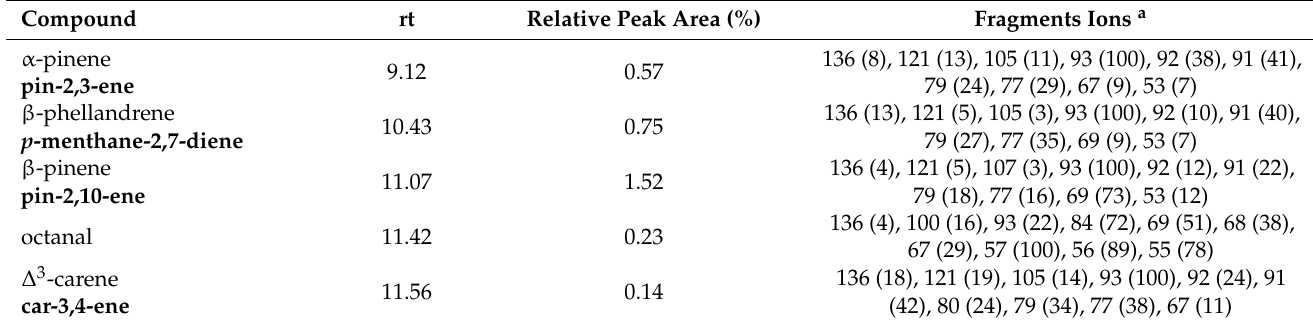
Table 1. Characterization of essential oil rich in